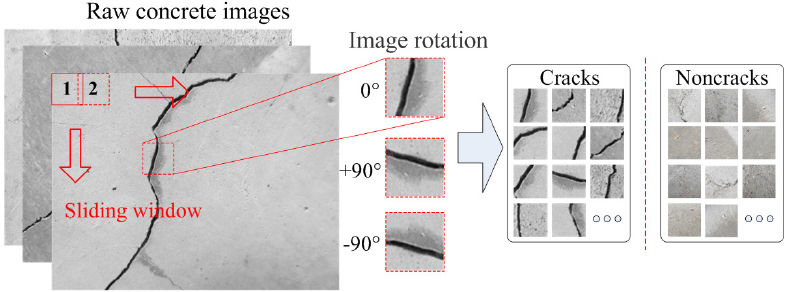
Figure 4. Illustration of the generation of the training database.